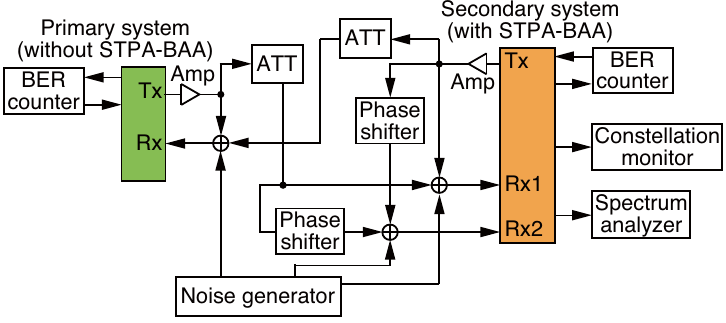
Figure 6. Experiment block diagram. BER: bit error rate; ATT: attenuator. Table 3. Experiment